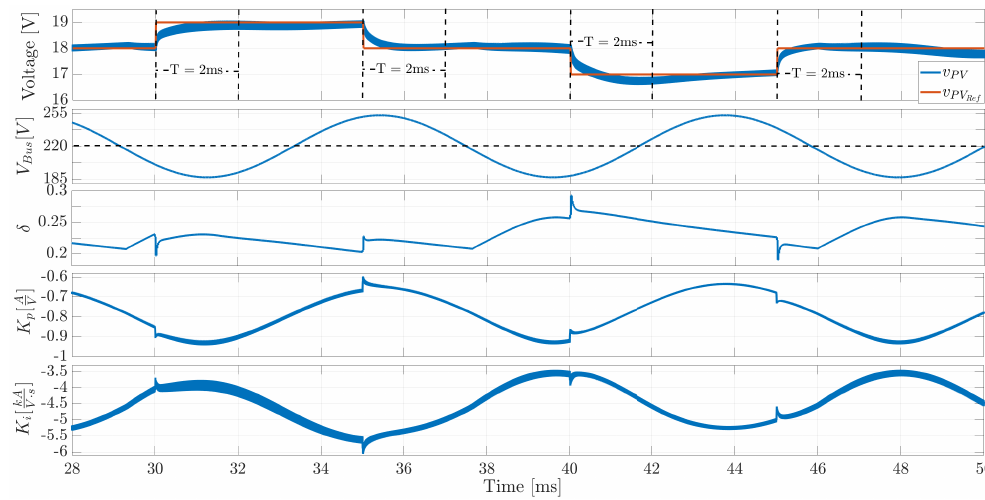
Figure 16. Performance of the control systems to step changes on the v PV reference and perturbations on the DC